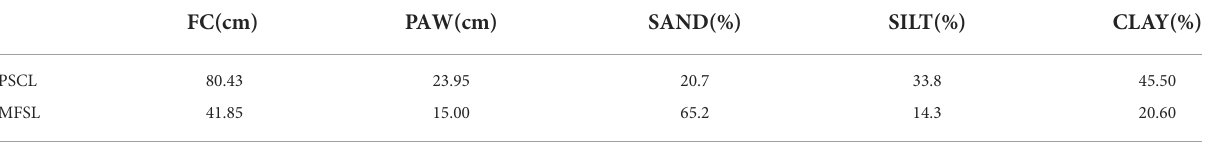
TABLE 1 Column integrated field capacity (FC) and plant available water (PAW), and column averaged sand-silt-clay composition for the PSCL and MFSL